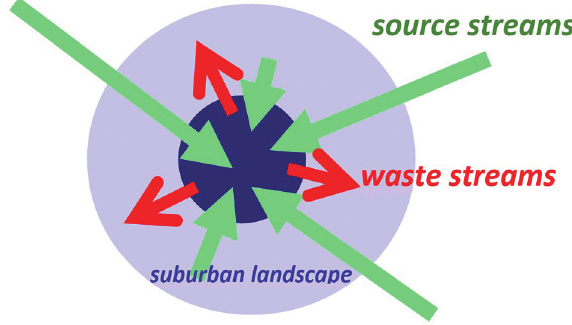
Fig. 1. Suburban landscape in the model of material and en- ergy flow between the city and the surrounding landscape. Processing by Kopp